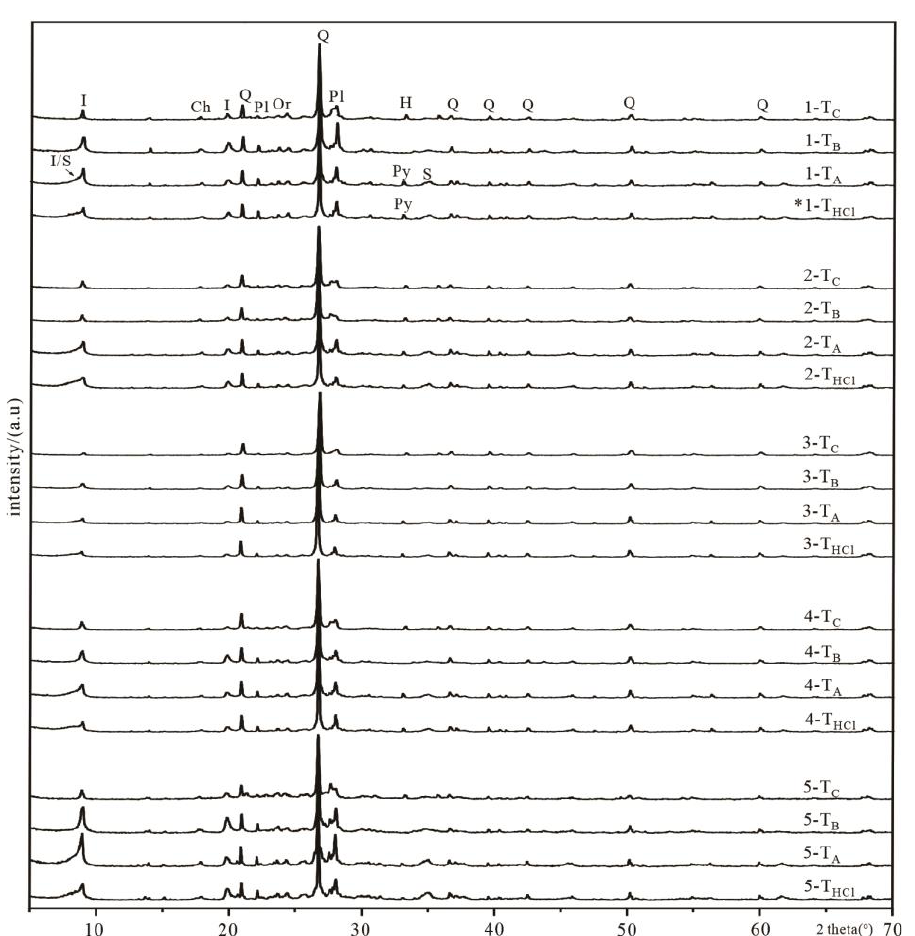
Figure 2. XRD pattern of T HCl and adsorbents. The identified minerals are Q: quartz; Or: orthoclase; Pl: plagioclase; Py: pyrite; H: hematite; I: illite; S: smectite; I/S: illite/smectite; and Ch: chlorite. * T HCl represents sample treated with hydrochloric acid.